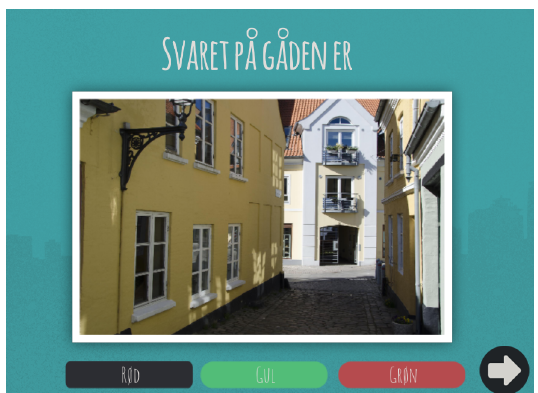
Figure 2. Controlquestionafter havingfoundthe